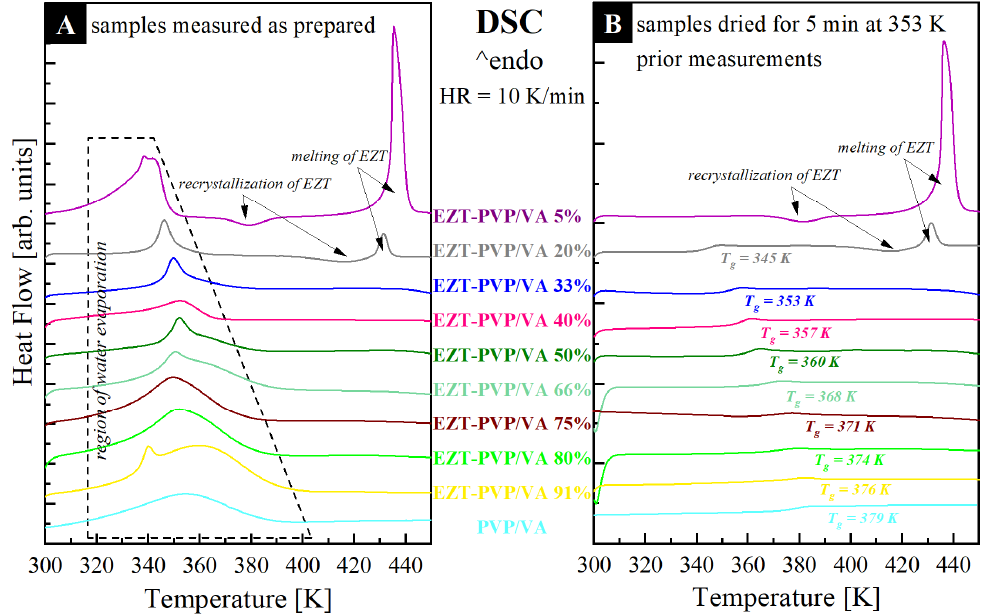
Figure 5. DSC thermograms of EZT-PVP/VA solid dispersions that were measured ( A ) as prepared and ( B ) before drying procedure performed for 5 min at 353 K .